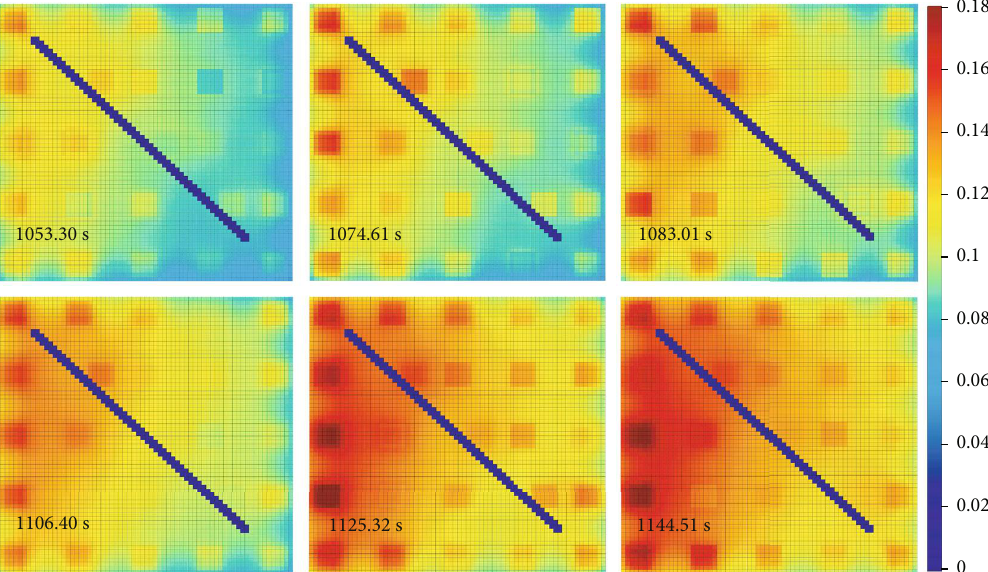
Figure 9: Di ff usion deduction model of AIRT increment under 22MPa before peak stress (black line indicates the prefabricated crack), reading from left to right and then up to the